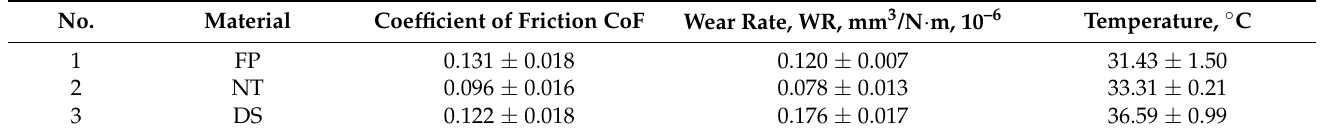
Table 5. The tribological properties of the PMMA dental materials in the linear tribological contact.